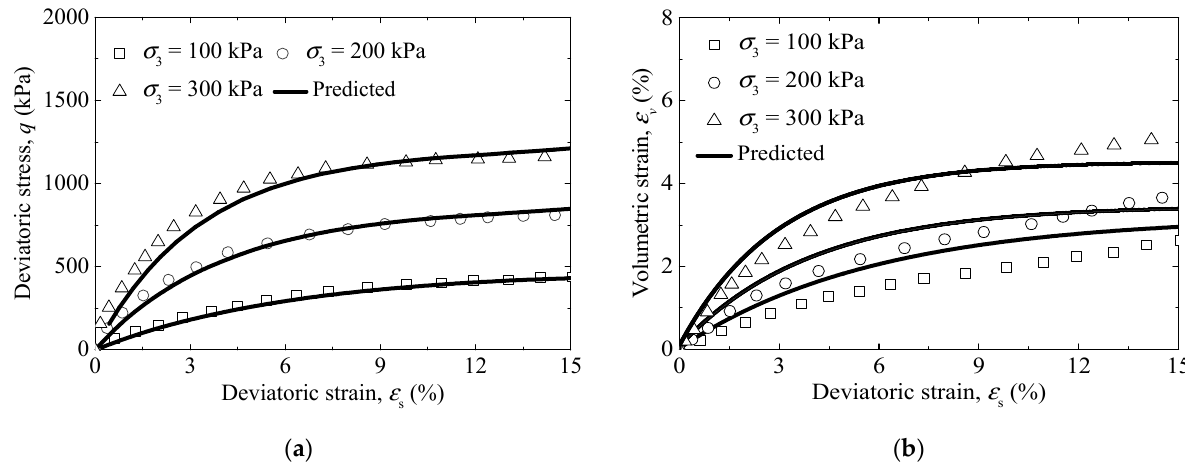
Figure 4. Comparison between predicted and observed results: ( a ) stress–strain curve, and ( b ) volumetric–deviatoric strain curve of bioenzyme-treated saturated soils (data from [37]). Table 3. Parameter values for the proposed elastoplastic model used in [37].